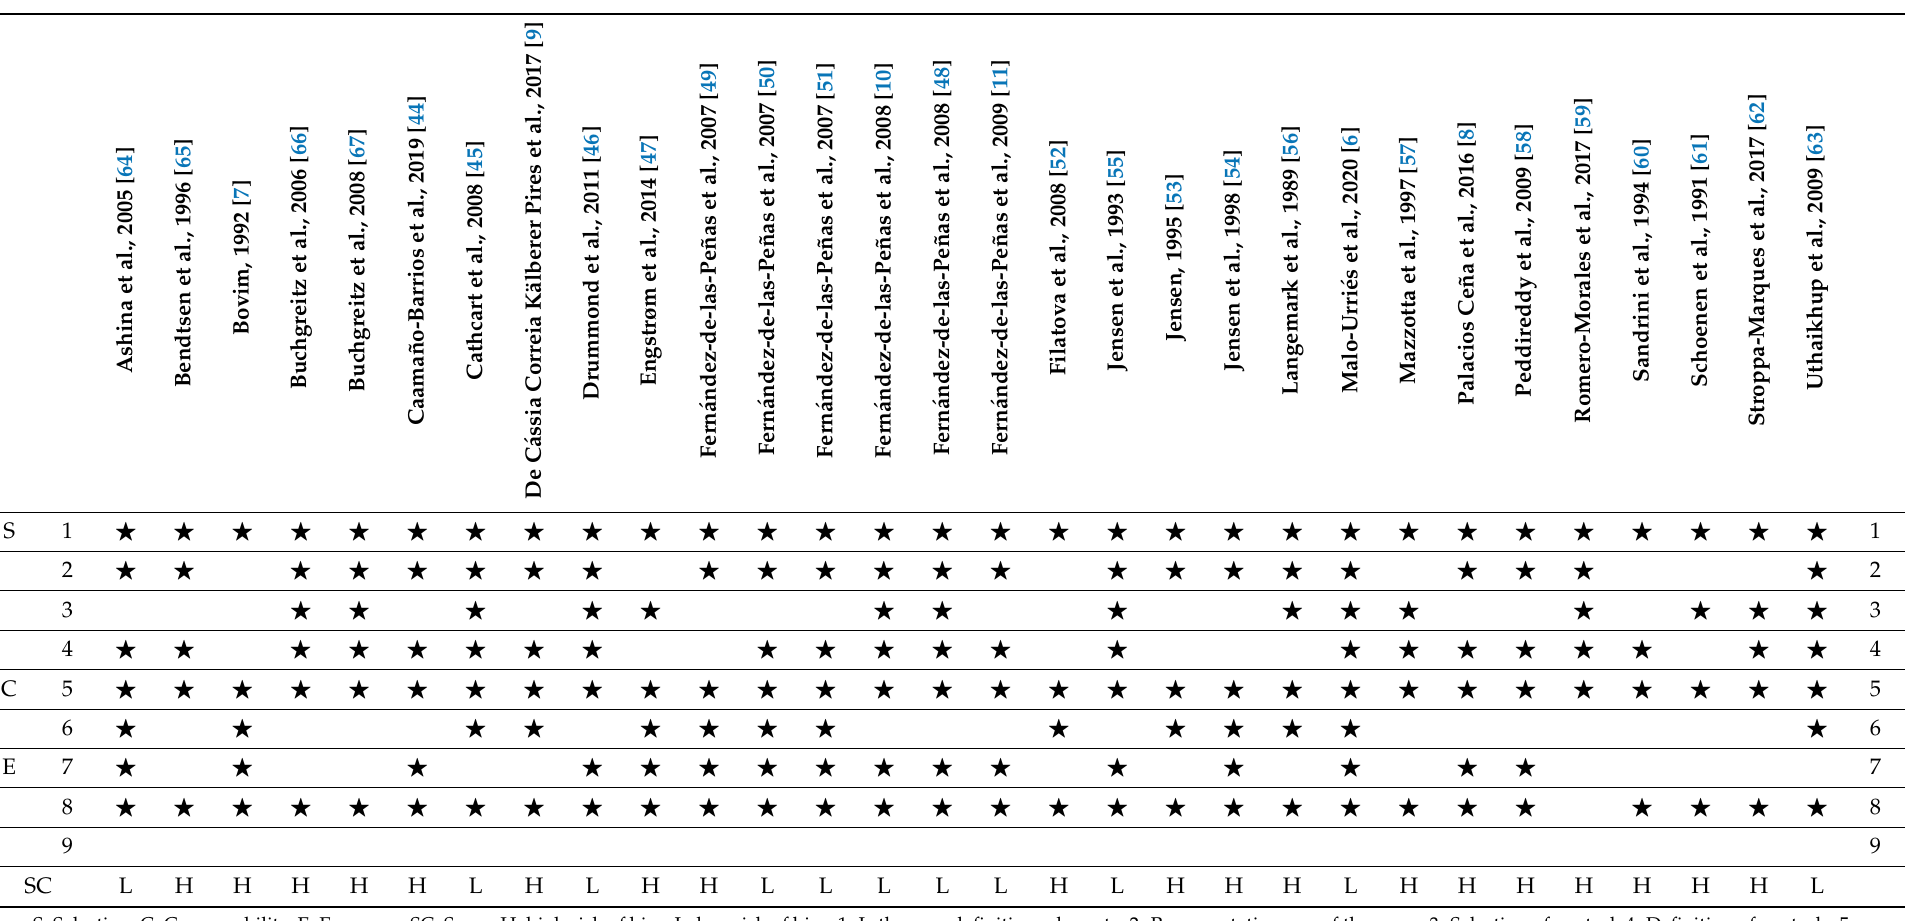
Table 5. Risk of bias (the Newcastle-Ottawa Scale) of the included tension-type headache (TTH)